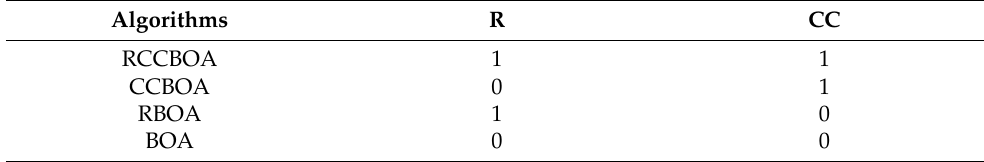
Table 3. Four BOA variants with two strategies.